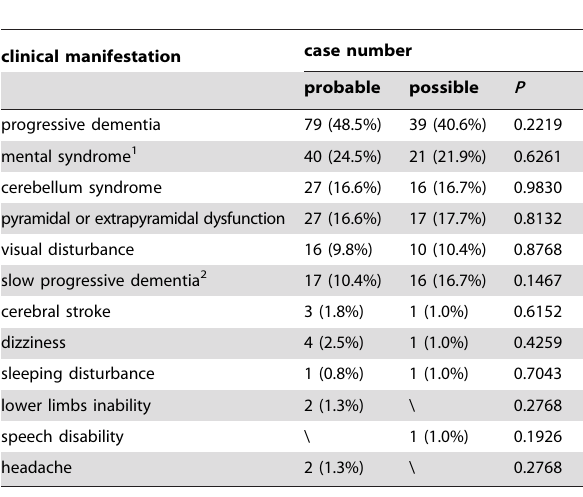
Table 1. The presenting symptoms of the probable and possible sCJD patients.